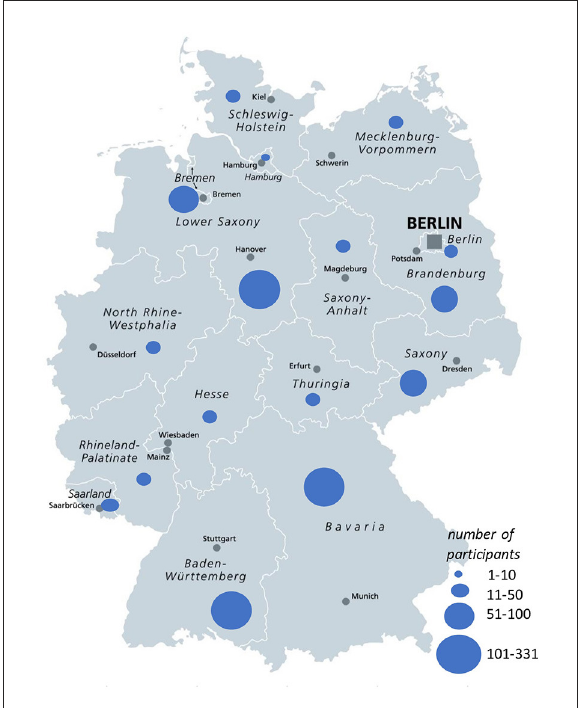
FIGURE3 Distribution of survey participants per federal state. Adapted by NL from Peter Hermes Furian–shutterstock.com, with